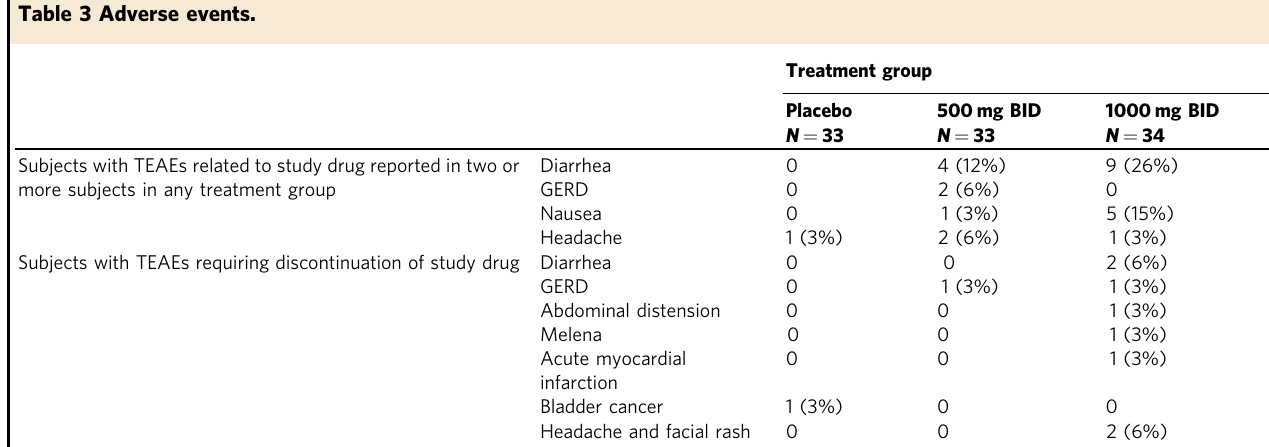
Table 3 Adverse